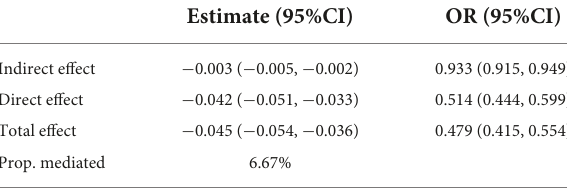
TABLE 2 Mediating effect of depression in the physical